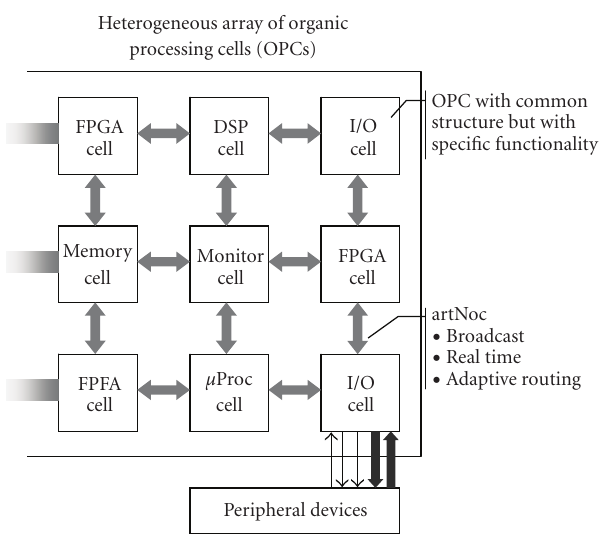
Figure 1: DodOrg organic hardware